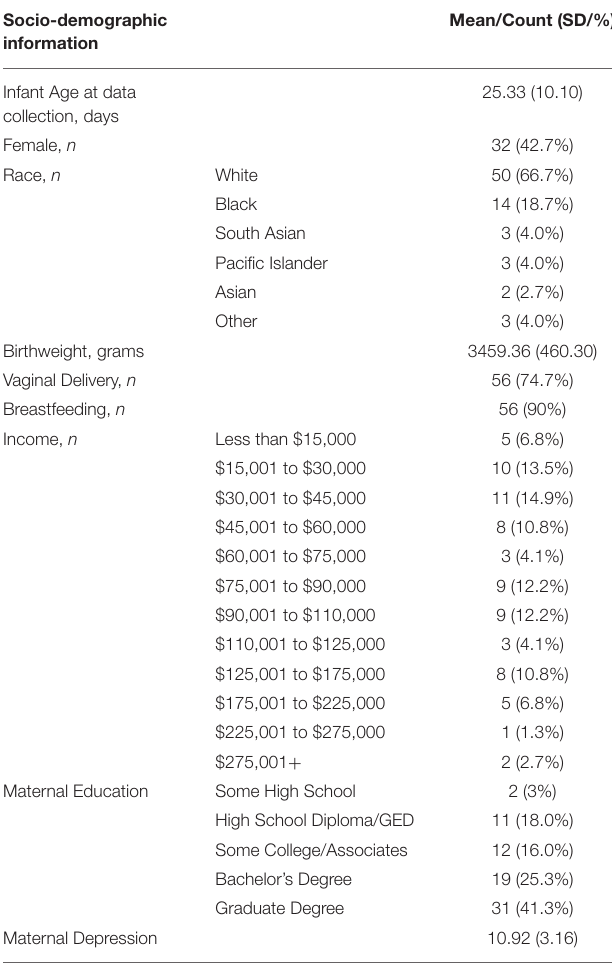
TABLE 1 | Socio-demographic information for the present study sample ( N = 75). Socio-demographic